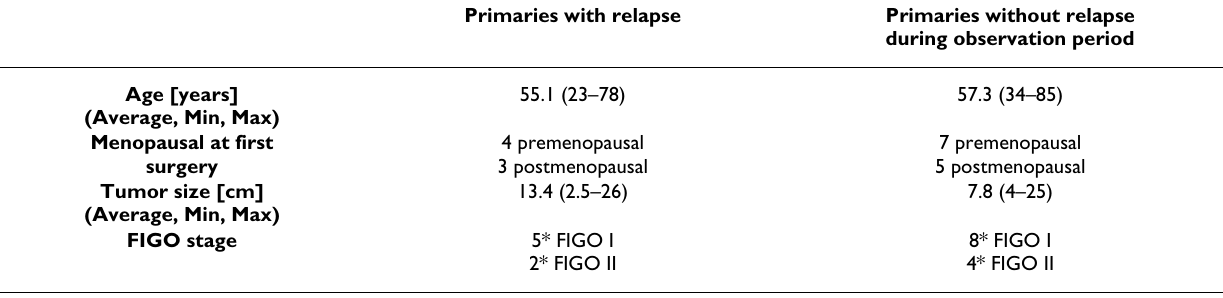
Primaries with relapse Primaries without relapse